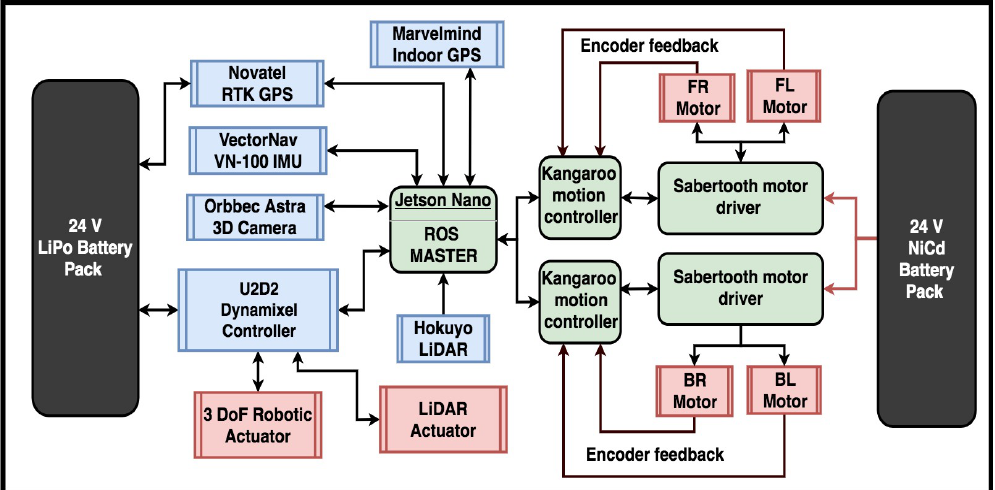
Figure 2. A diagram of the overall system design for